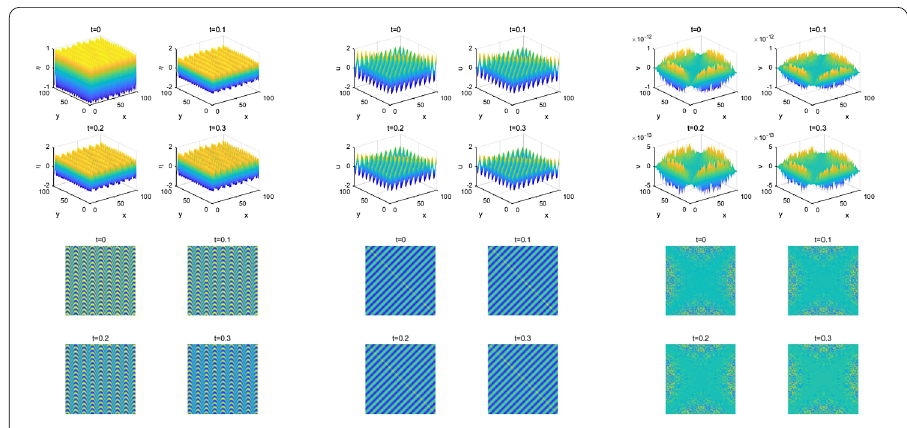
Figure 11 Numerical solution and pattern of Experiment 3, for initial conditions see Table 3